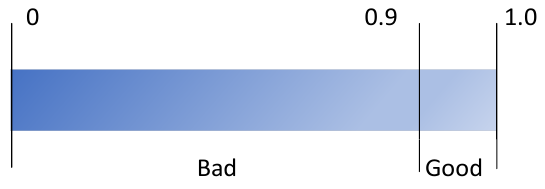
Figure 3. Link quality of the division diagram.